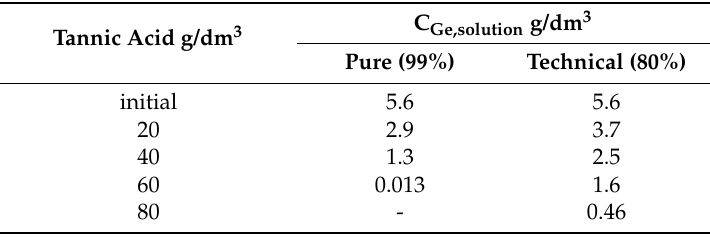
Table 6. Concentration of germanium after precipitation with pure and technical tannic acid powder (90 ◦ C, tannic acid added in portions, 1 h between